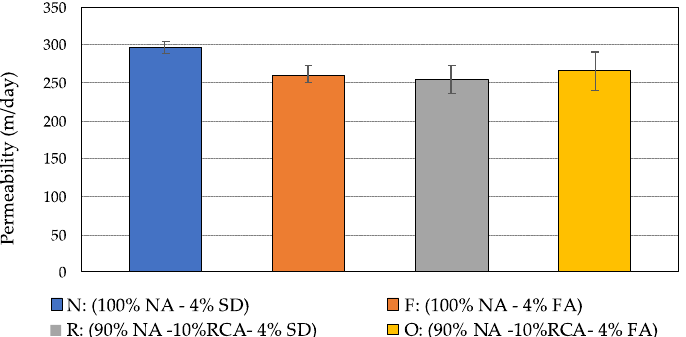
Figure 7. Average permeability coefficient of the four porous asphalt mixtures.